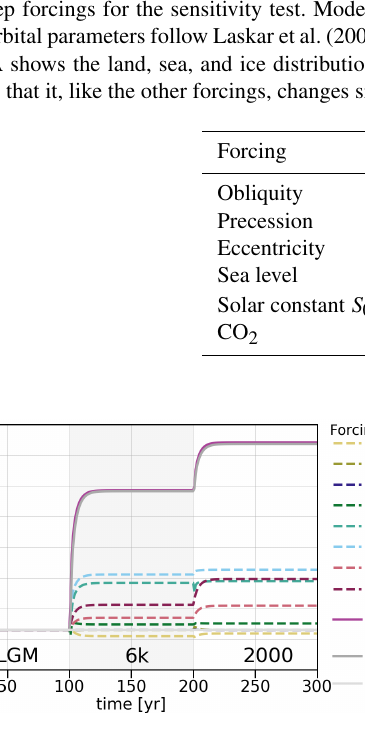
Figure 13. Test of the sensitivity of the model to the different forc- ings. Conditions for three different states, which cover a large range in forcings, are simulated as described in Table 8. When forcings are applied one at a time, the sum of the temperature change differs slightly from when they act altogether, indicating some nonlinear model behavior. Changes to CO 2 and the distributions of ice sheets and sea ice affect GMT the